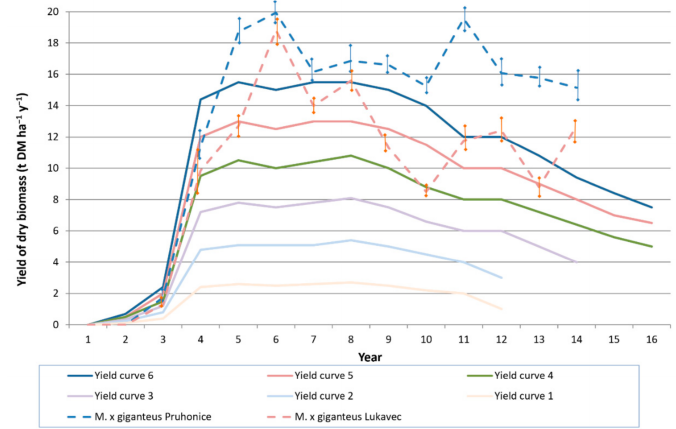
Figure 4. Dry biomass yields of Miscanthus × giganteus (average with standard error bars of clones M1, M2) from plantations in Pr˚uhonice-Michovky and Lukavec, and yield curves (Yc 1–6) of expected yields in commercial practice created for different growing zones for Miscanthus in the Czech Republic; growing years (1–16) are considered as financial years (e.g., from January to